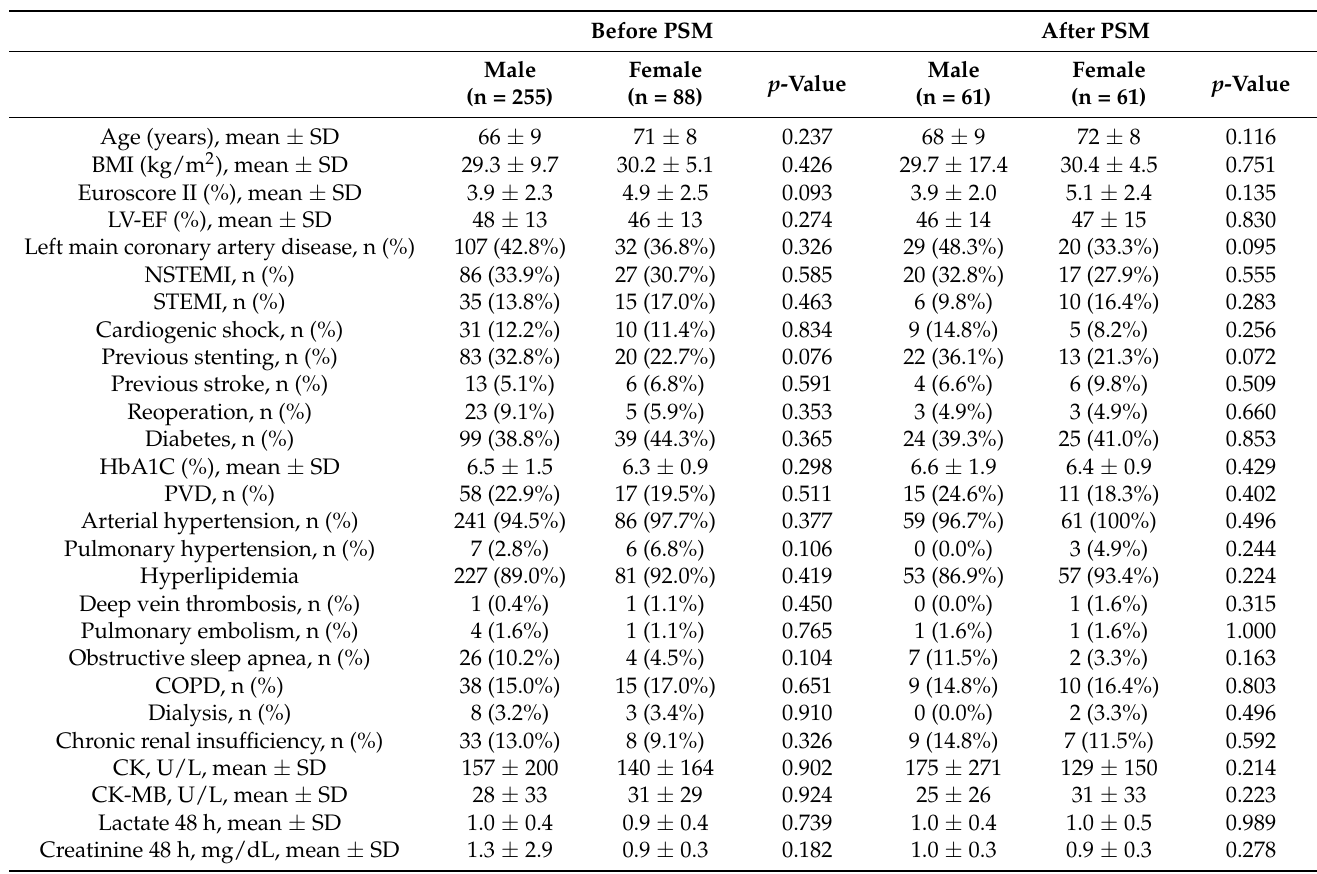
Table 1. Preoperative